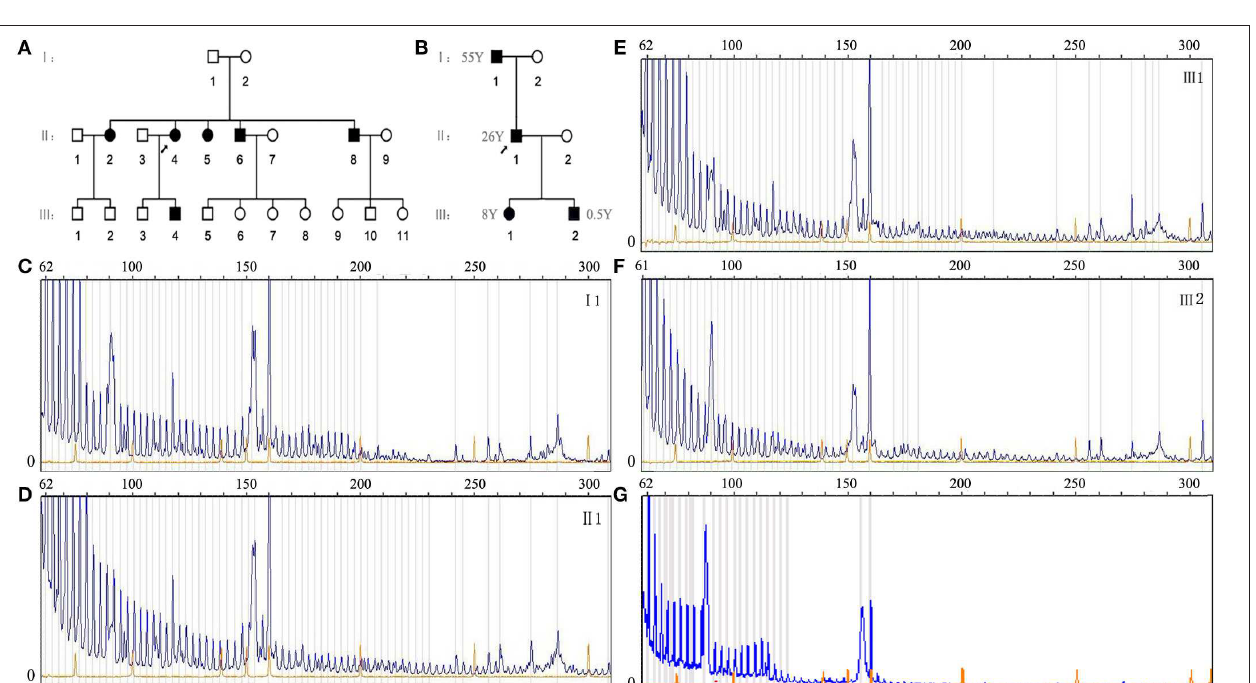
Frontiers in Neurology |